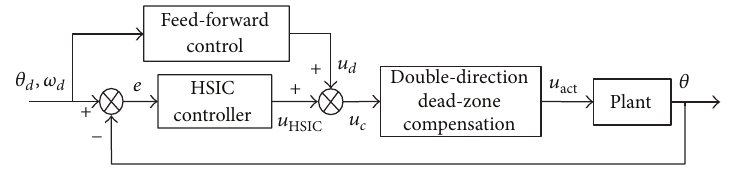
Figure 2: Block diagram of joint motion control.